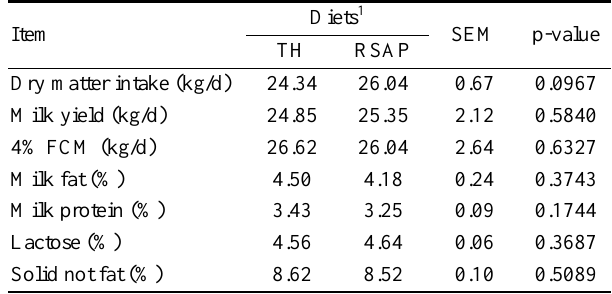
Table 3. Dry matter intake, milk production and composition of cows fed experimental diets